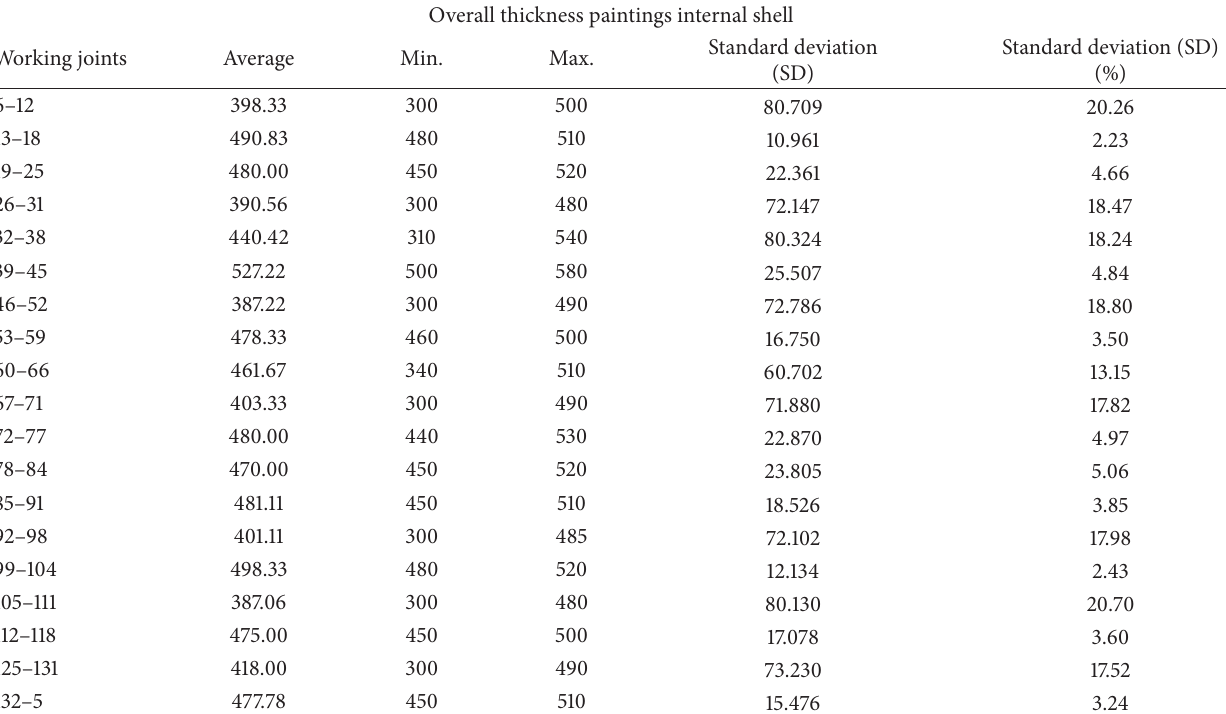
Table 6: Organic coating total thickness ( 𝜇 m) on the surface concrete of internal shell (above the